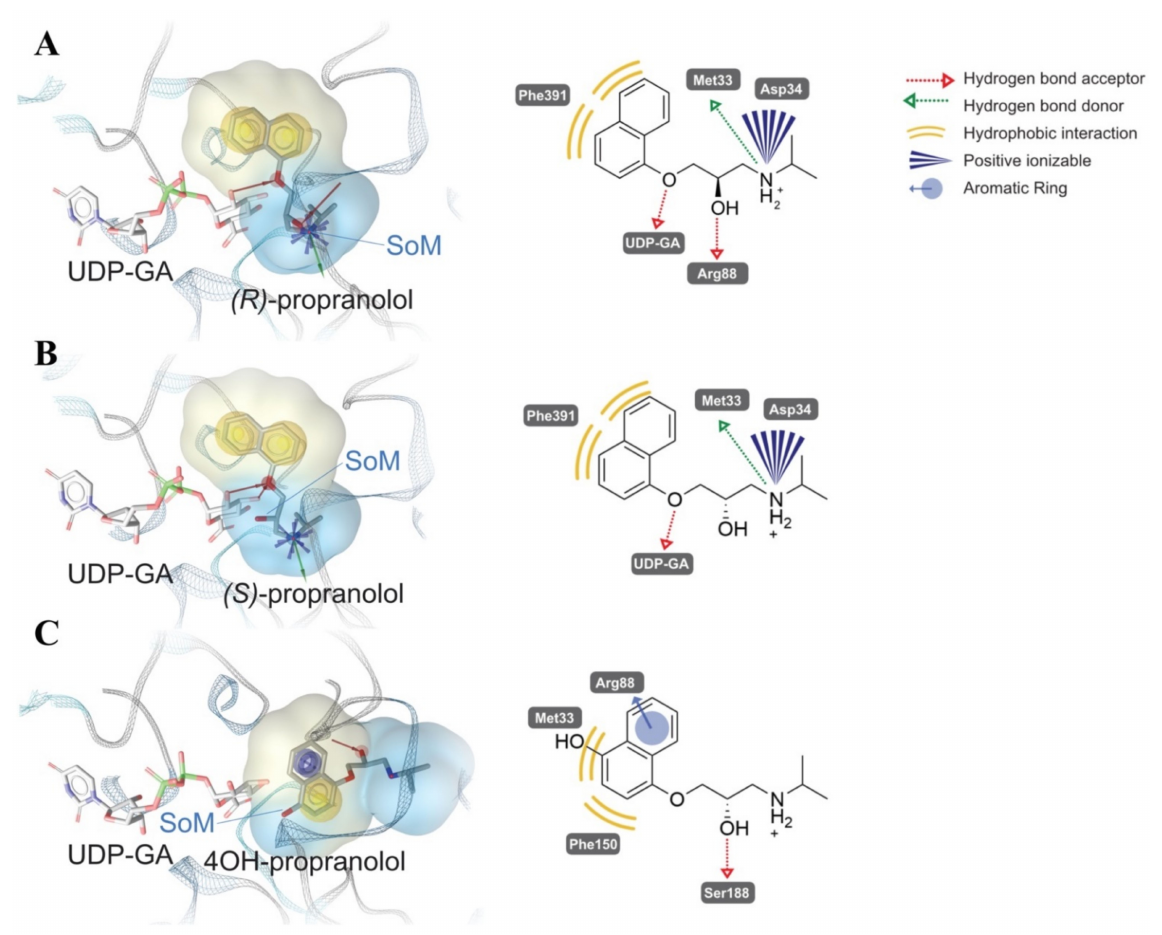
Figure 8. Suggested conformations of ( R )-propranolol ( A ), ( S )-propranolol ( B ) and 4-hydroxypropranolol ( C ) binding in the human UGT1A7 homology model. Three-dimensional pharmacophores were generated to present the interactions between propranolol and UGT1A7. SoM: Site of